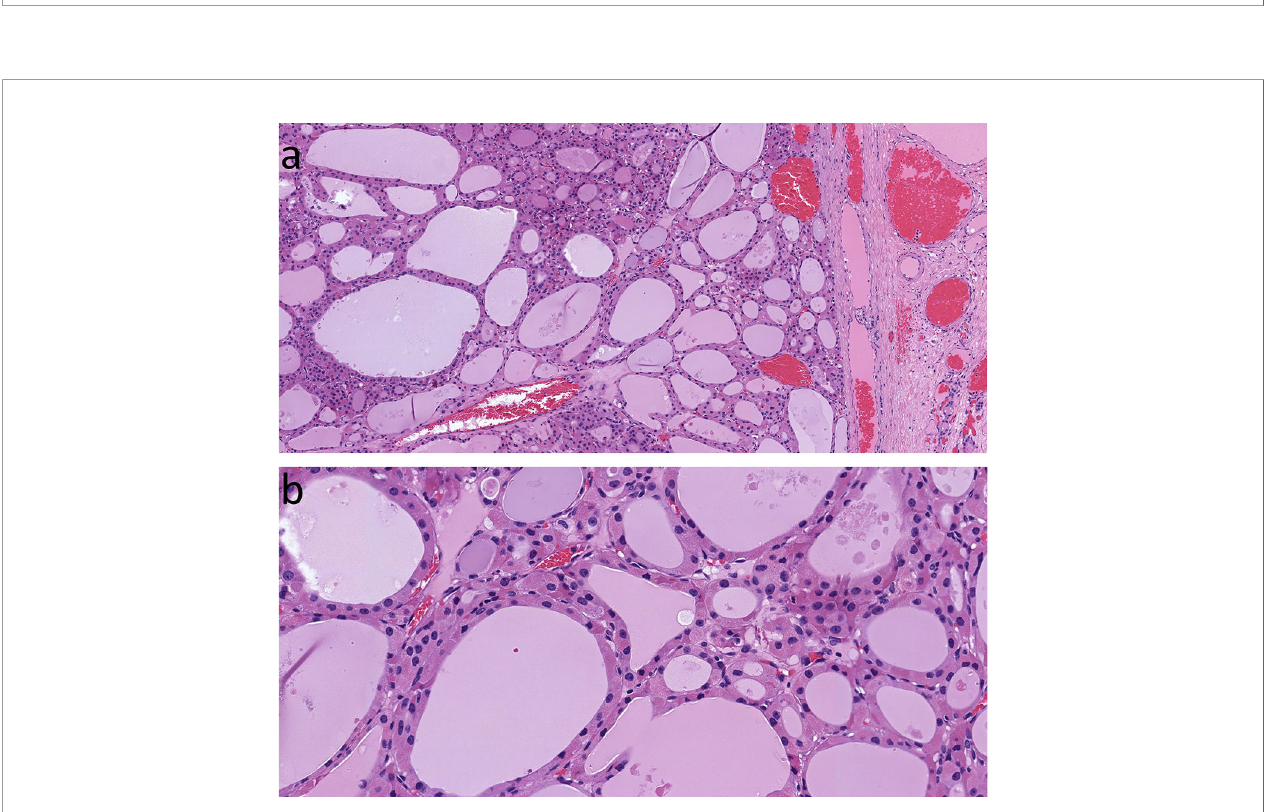
FIGURE 4 | Oncocytic Follicular Thyroid Adenoma. This large, solitary neoplasm of thyroid follicular cells with follicular architecture is well delineated (A) , and has bland nuclear morphology (B) with no evidence of invasive behavior at the capsule.